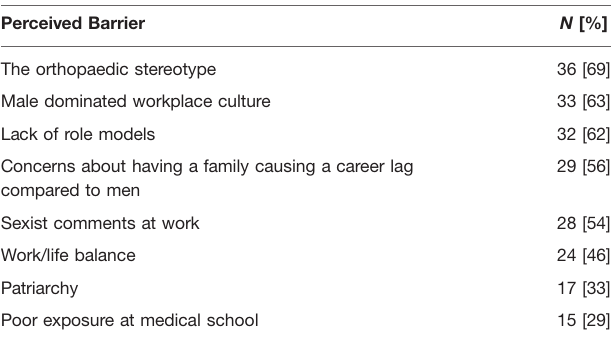
TABLE 1 | Perceived barriers to women entering a career in orthopaedics identi fi ed in the post-event questionnaire ( n =52). Perceived Barrier